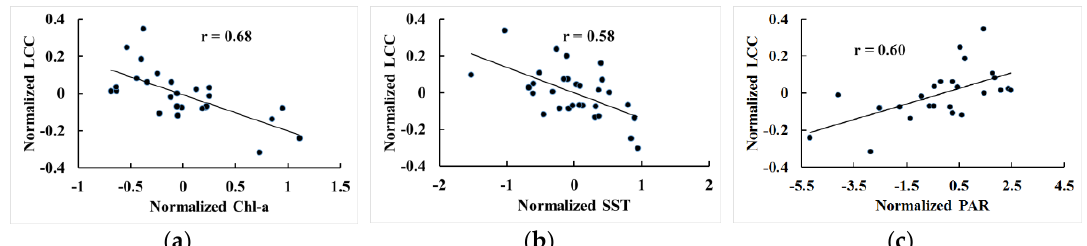
( b ) ( c )   v.s. LCC  ; ( b ) SST Chl y 1 y  2 y 